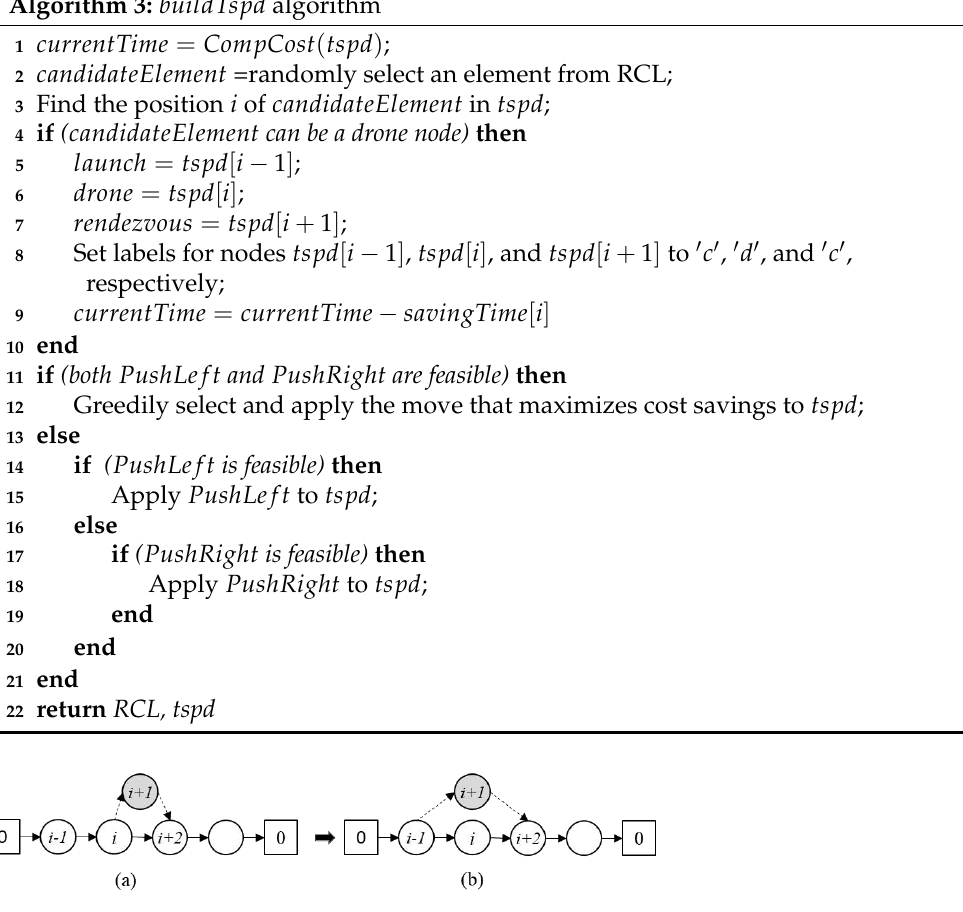
Figure 4. PushLeft move: ( a ) displays the current solution before applying PushLeft ; and ( b ) displays the solution after applying PushLeft